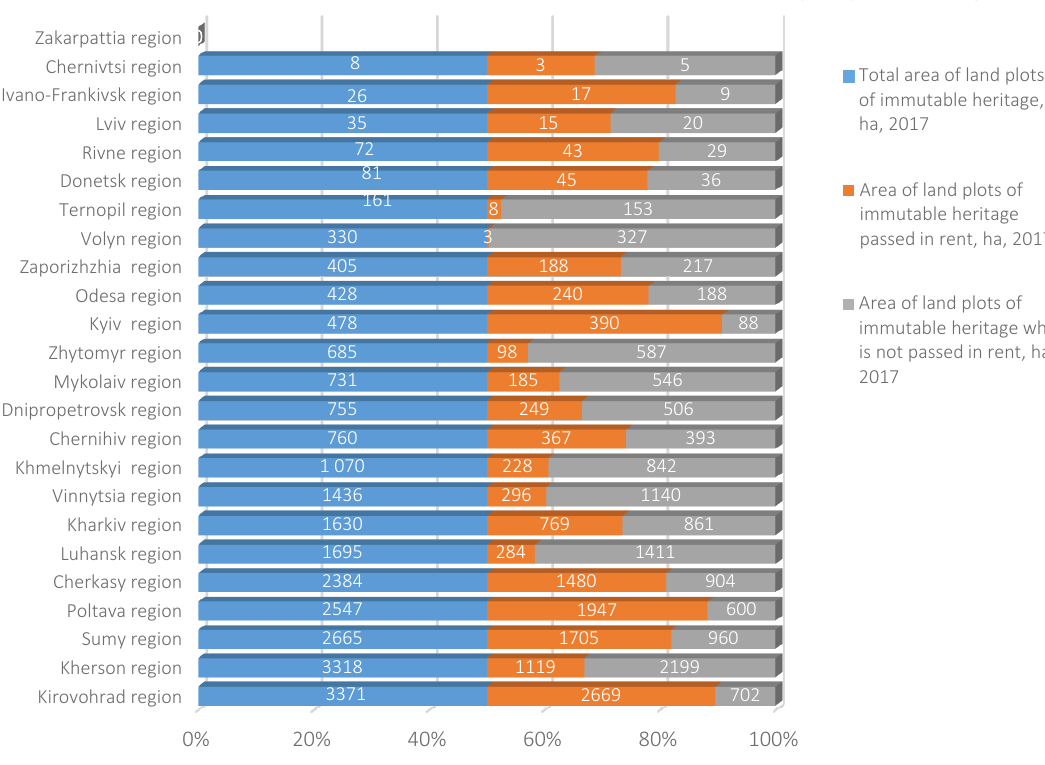
Figure 5. Classification of land plots which belong to immutable